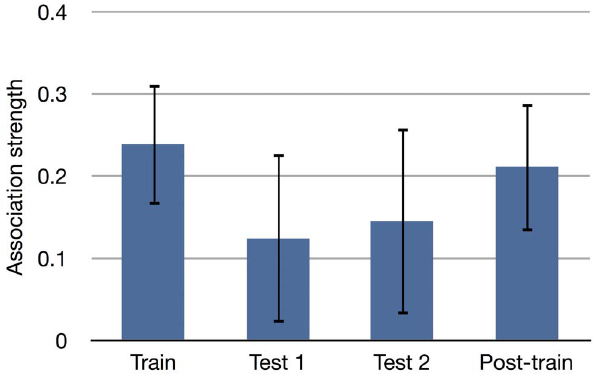
Figure 2. Number of associations. Number of associations for prime words in the test blocks.